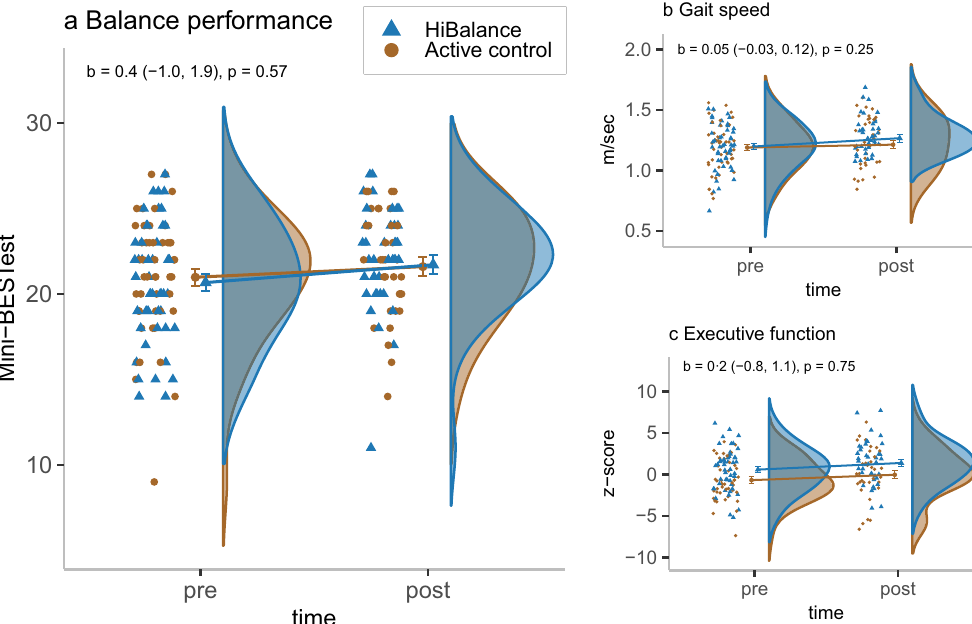
Fig. 2 Effects of the HiBalance programme. The mean values, the standard error of the mean (error bars) as well as the b values, e.g., the unstandardised estimates of the time by group interaction, and their 95% CIs, are predicted values based on the intention to treat analyses. The participants ’ point estimates, and their distributions are observed values. a Mini-BESTest (range 0 – 28), b Gait speed (m/s), c executive function (composite score of four tests from the Delis – Kaplan Executive Function System and the Wechsler Adult Intelligence Scale, z